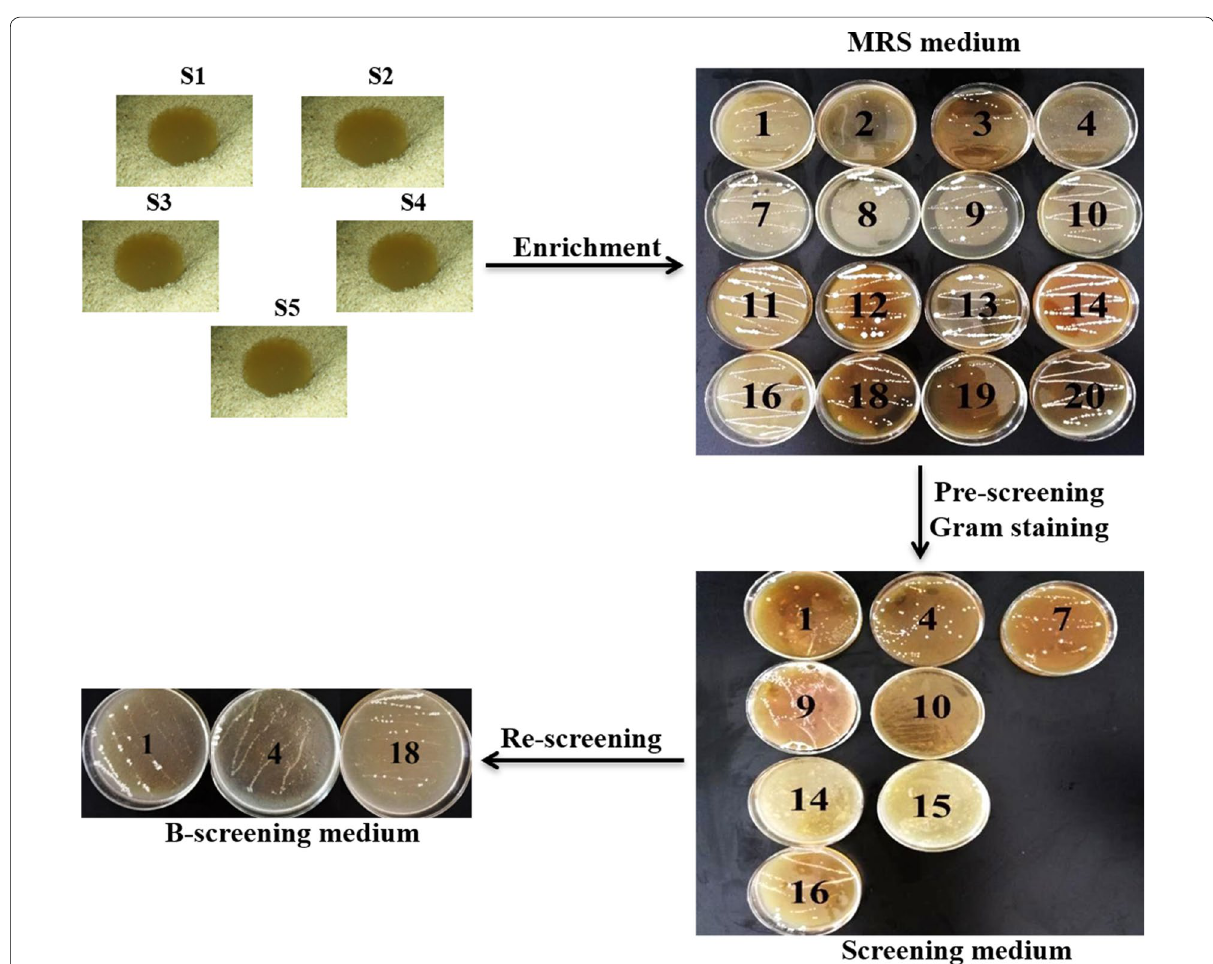
Fig. 1 Flow chart for the isolation of LAB with lipolytic capacity. Vinasses were sampled from the wine factory. After enrichment on the MRS medium, 16 strains with LAB-like morphology were firstly selected. Using screening medium for prescreening, 8 strains were isolated which could grow on the medium as well as Gram-positive. Moreover, strain 1, 4, 18 were successfully re-screened with the B-rescreening medium